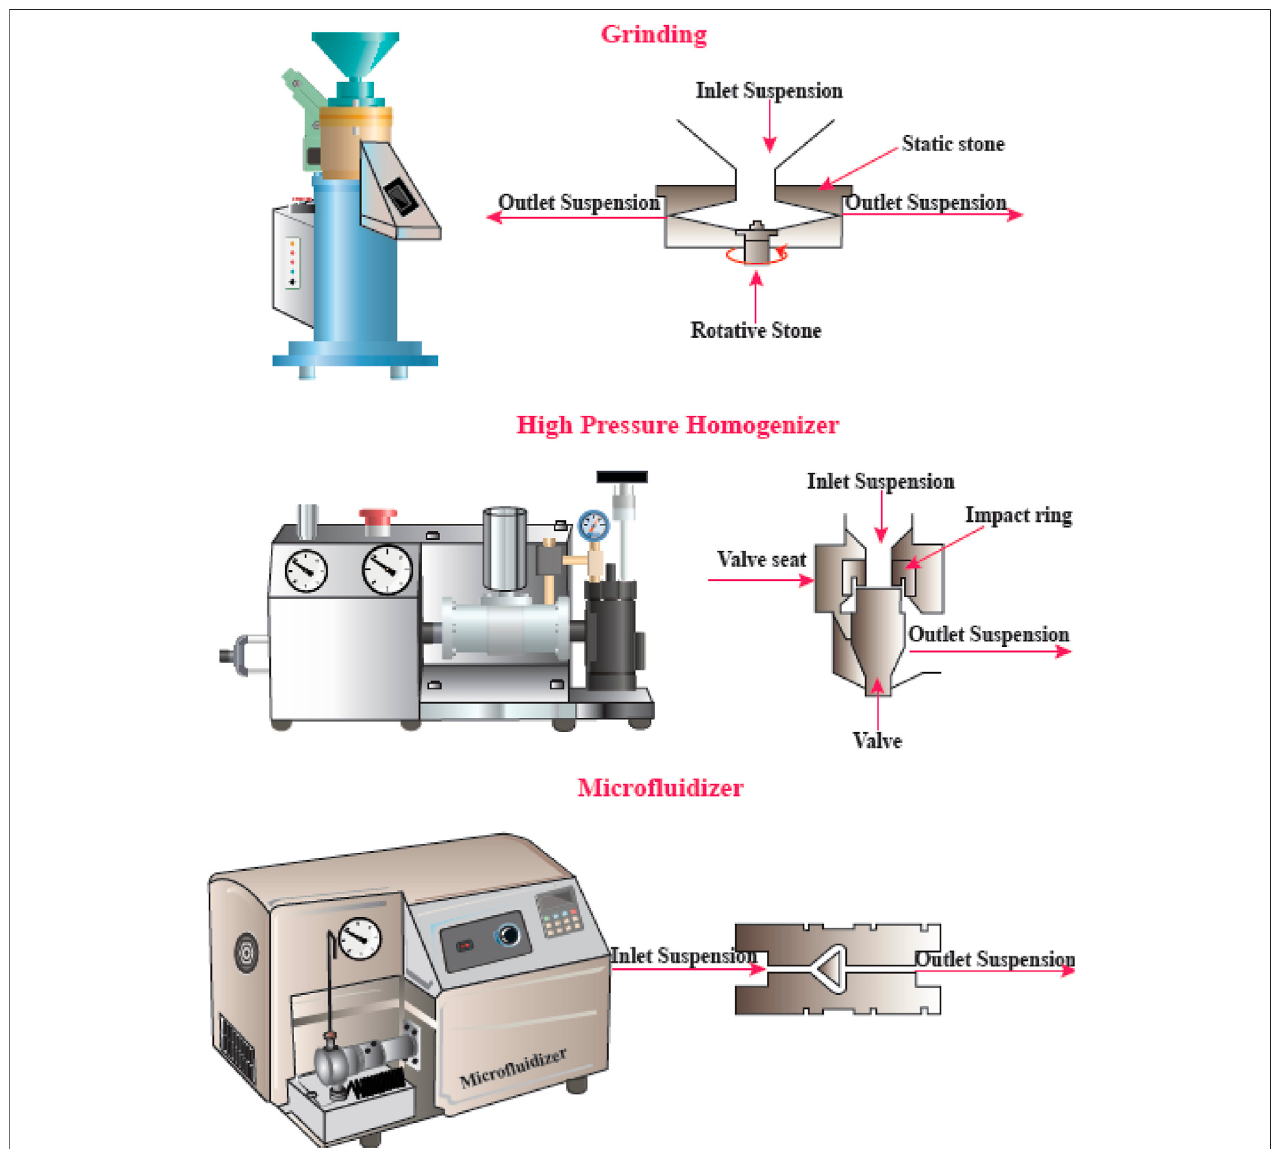
FIGURE 4 | Mechanical methods for CNF production. This fi gure adapted from www.niro-soavi.com, www.micro fl uidicscorp.com and www.masuko.com.